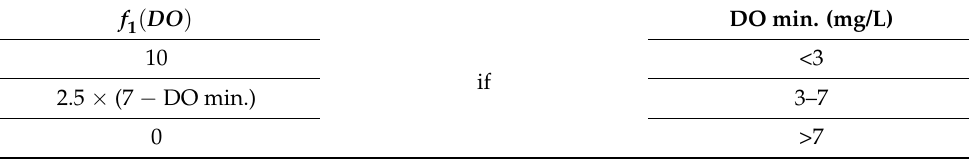
Table 3. The ranges used to assign values for Dissolved Oxygen.